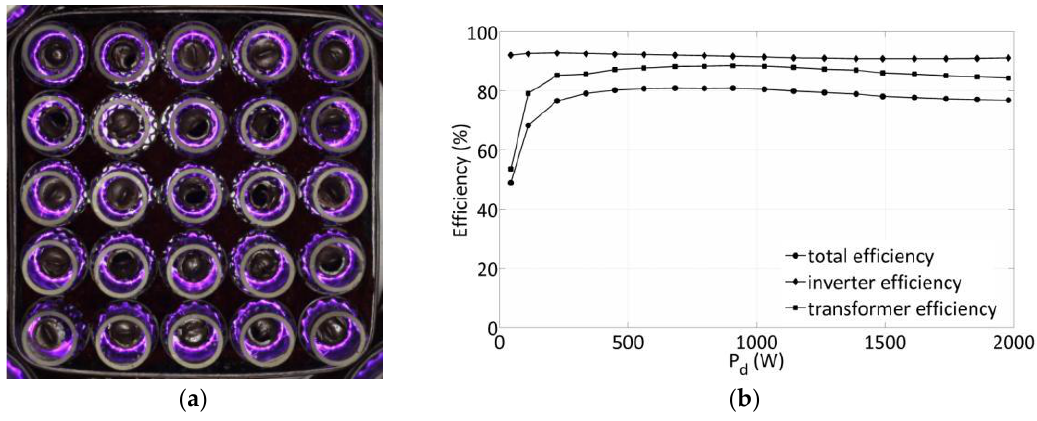
Figure 21. DBD reactor construction for diesel engine exhaust treatment (b) results of efficiency measurements of power electronic diagonal bridge resonant converter [36,56].